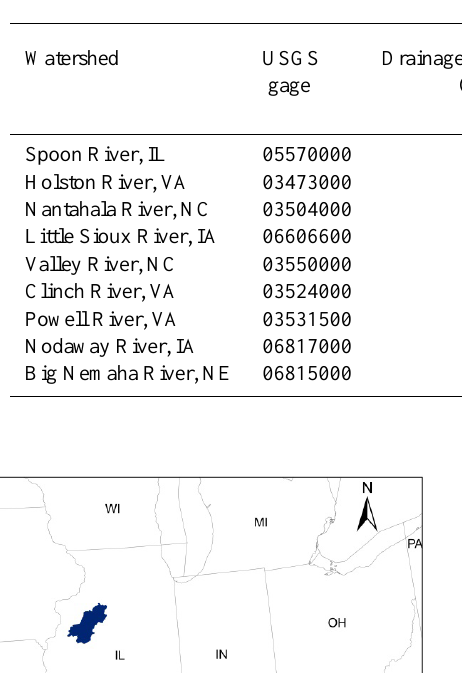
Table 1. Watershed name, USGS gage number, drainage area, climate aridity index ( E p /P) , and estimated recession parameters for the 9 case study watersheds.